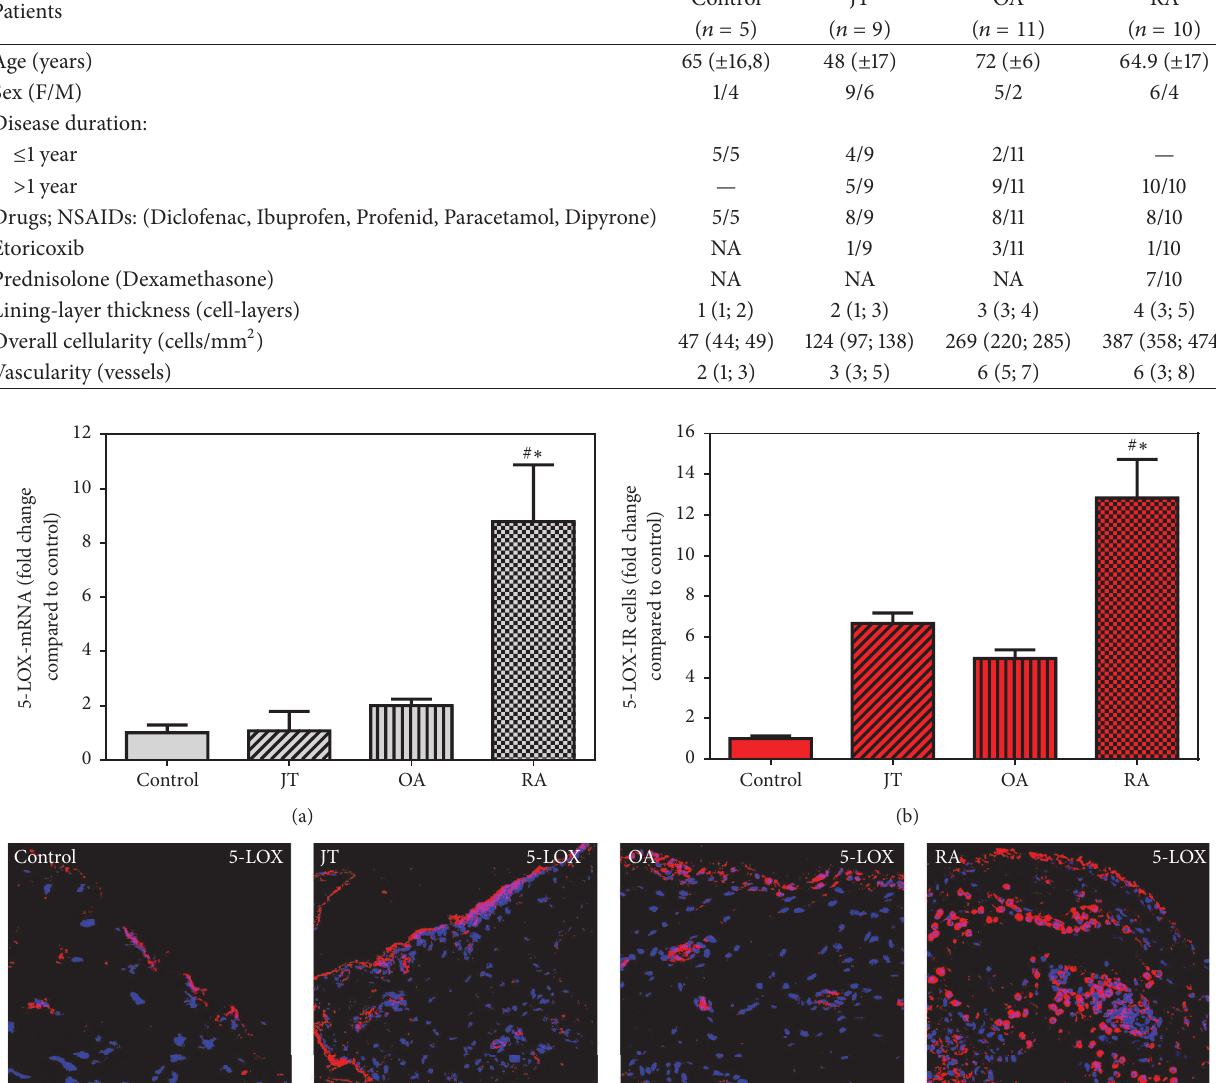
Table 1: Clinical and histological characteristics of patients with joint trauma, osteoarthritis, and rheumatoid arthritis. Patients